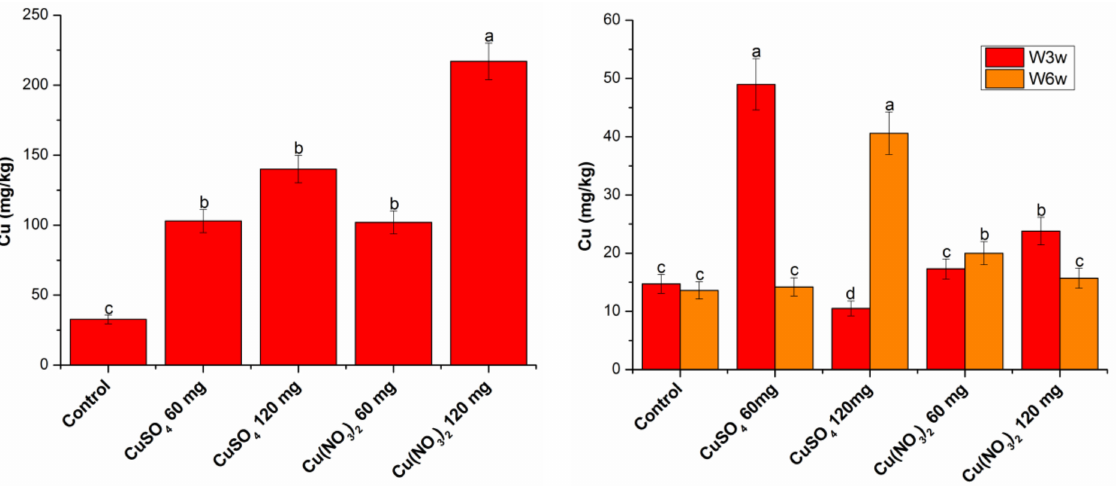
Figure 7. Copper content in root ( left ) and aerial part ( right ) when different concentrations of CuSO 4 and Cu(NO 3 ) 2 were applied; different letters mean significant differences between the treatment and the control plants, determined by Tukey’s test ( p <